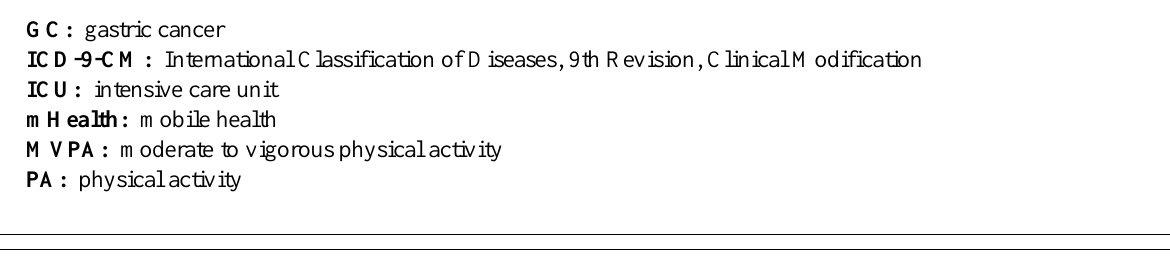
ICD-9-CM: International Classification of Diseases, 9th Revision, Clinical Modification ICU: intensive care unit